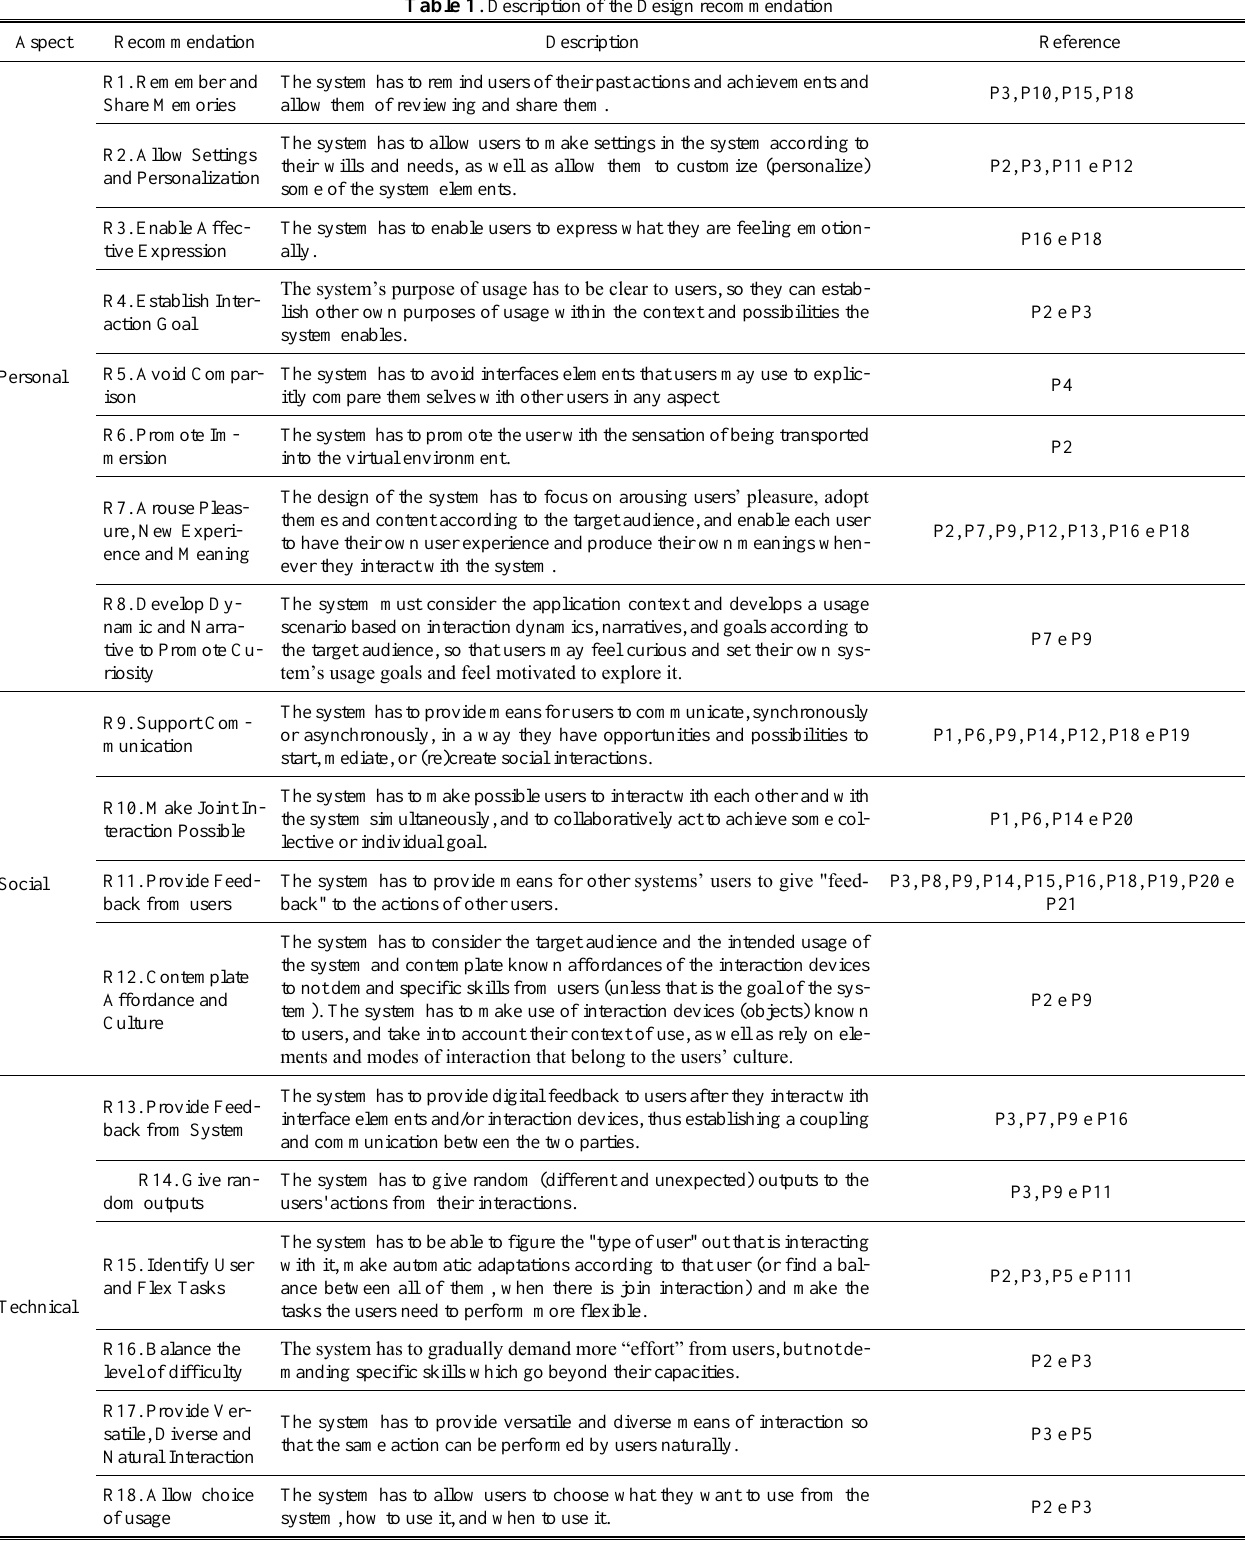
Table 1 . Description of the Design